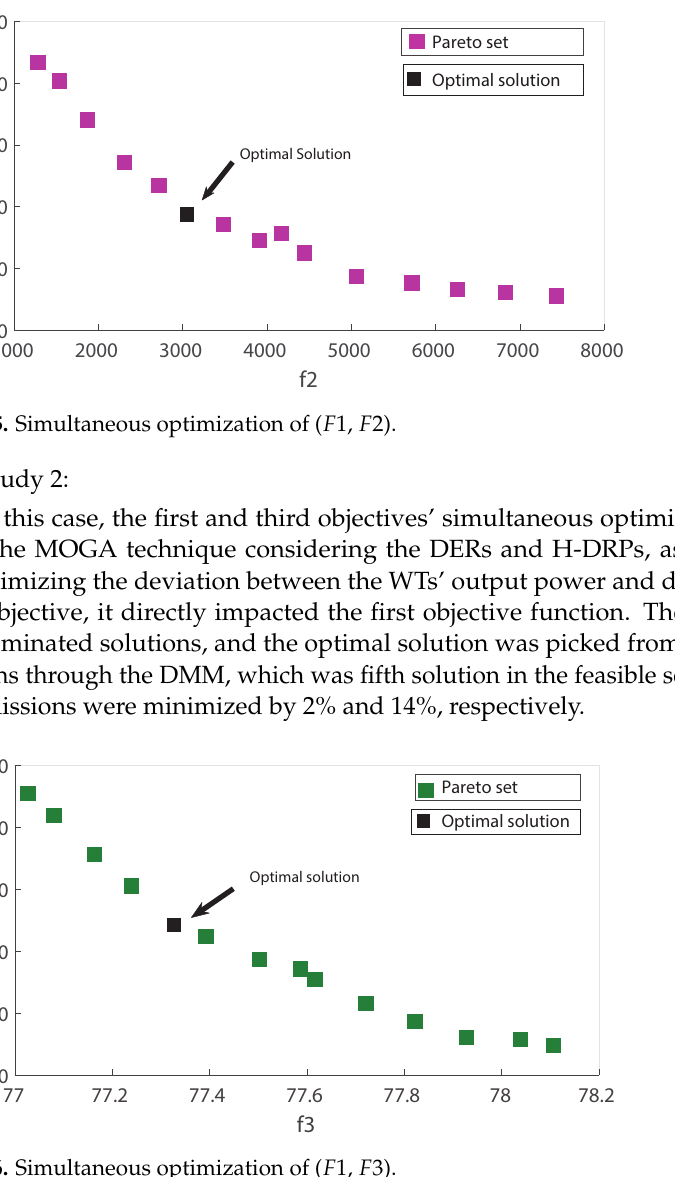
Figure 6. Simultaneous optimization of ( F 1, F